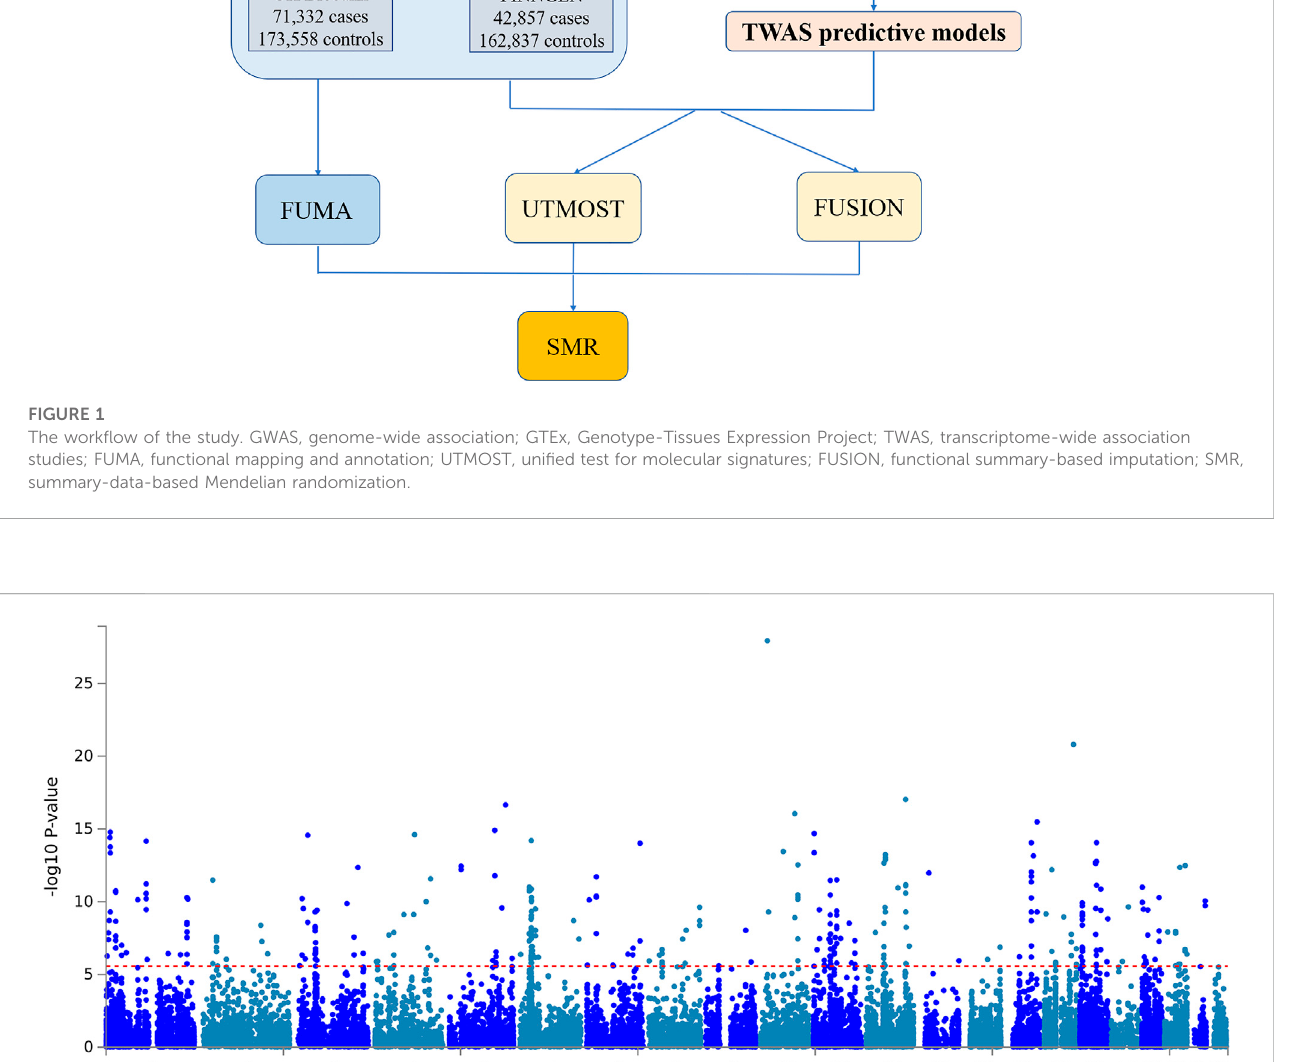
expression, RNA biological processes, which explains the heritability of hypertension.